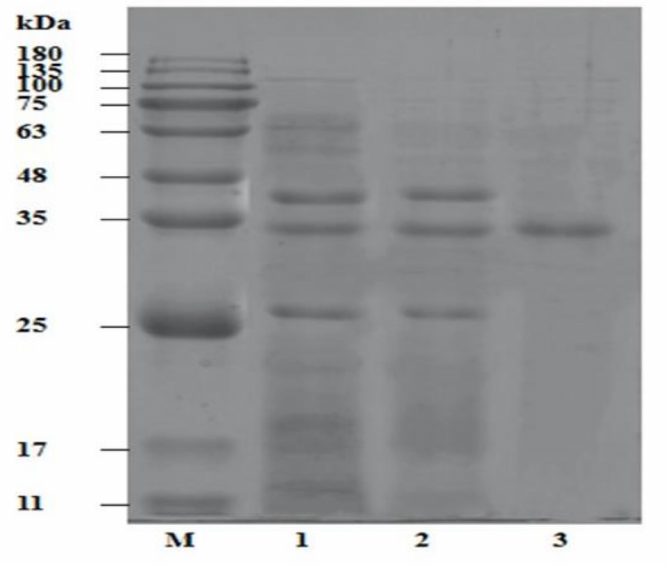
Figure 2. SDS-PAGE of the trypsin from Litopenaeus vannamei . Lanes: M, protein marker; 1, crude enzyme; 2, ammonium sulfate fractional precipitation; and 3, Q-Sepharose anion chromatography column. Representative results from repeated experiments were